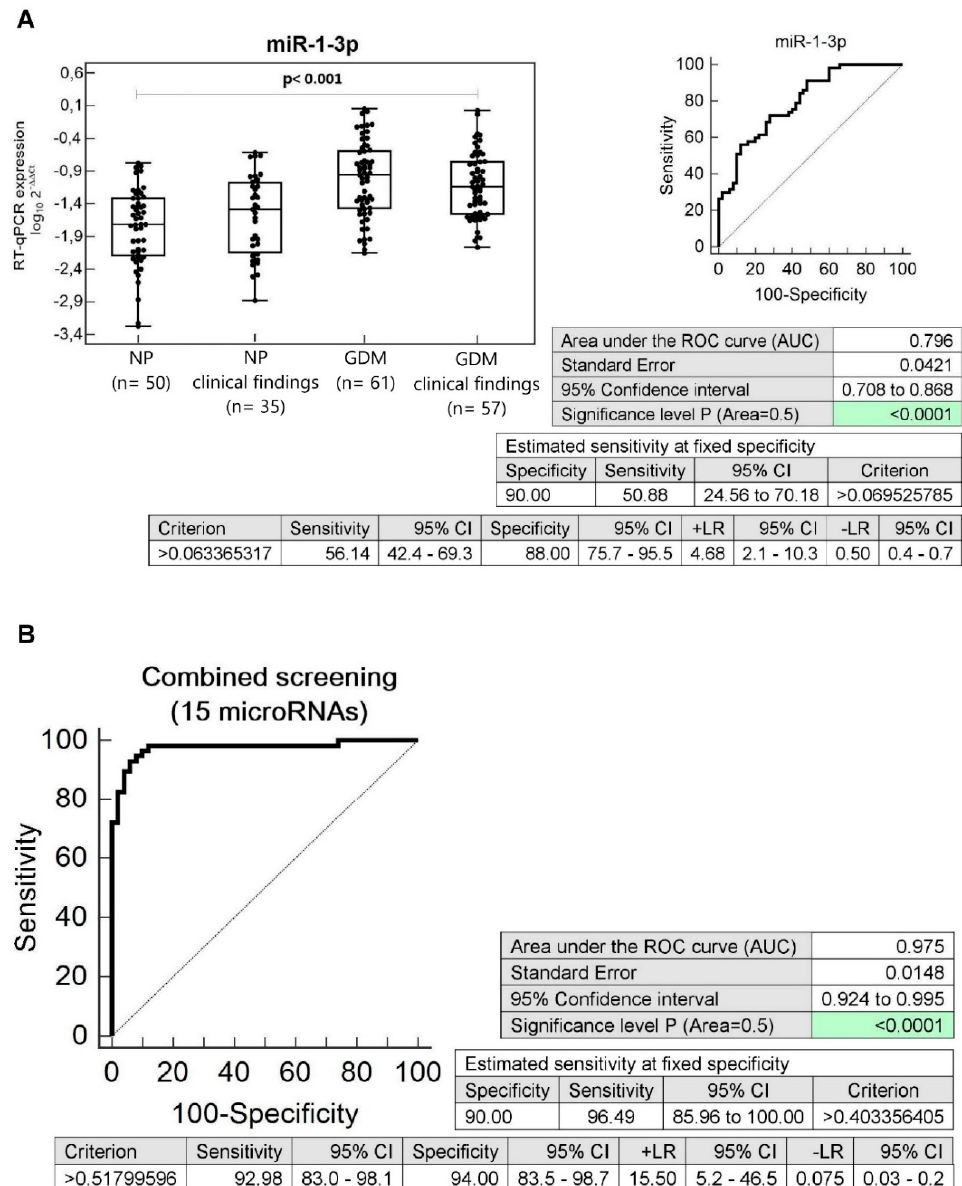
Figure 4. Aberrant microRNA expression profile in children descending from GDM complicated pregnancies with abnormal clinical findings. ( A ) Upregulation of miR-1-3p was observed in children descending from GDM complicated pregnancies with abnormal clinical findings, when the comparison to the controls with normal clinical findings was performed. Concerning individual microRNAs, miR-1-3p showed the highest accuracy for the identification of children at a higher risk of later development of diabetes mellitus and/or cardiovascular/cerebrovascular diseases. ( B ) Combined screening of microRNAs in the identification of children prenatally exposed to GDM with abnormal clinical findings at an increased risk of later development of diabetes mellitus and / or cardiovascular / cerebrovascular diseases. Screening based on the combination of microRNAs with a good sensitivity (miR-1-3p, miR-17-5p, miR-20a-5p, miR-20b-5p, miR-21-5p, miR-29a-3p, miR-92a-3p, miR-103a-3p, miR-126-3p, miR-133a-3p, miR-143-3p, miR-181a-5p, miR-195-5p, miR-221-3p, and miR-499a-5p) showed the highest accuracy for the identification of children prenatally exposed to GDM with abnormal clinical findings at a higher risk of later development of diabetes mellitus and / or cardiovascular / cerebrovascular diseases. The comparison to the controls with normal clinical findings was performed. NP: Normal pregnancies; GDM: Gestational diabetes